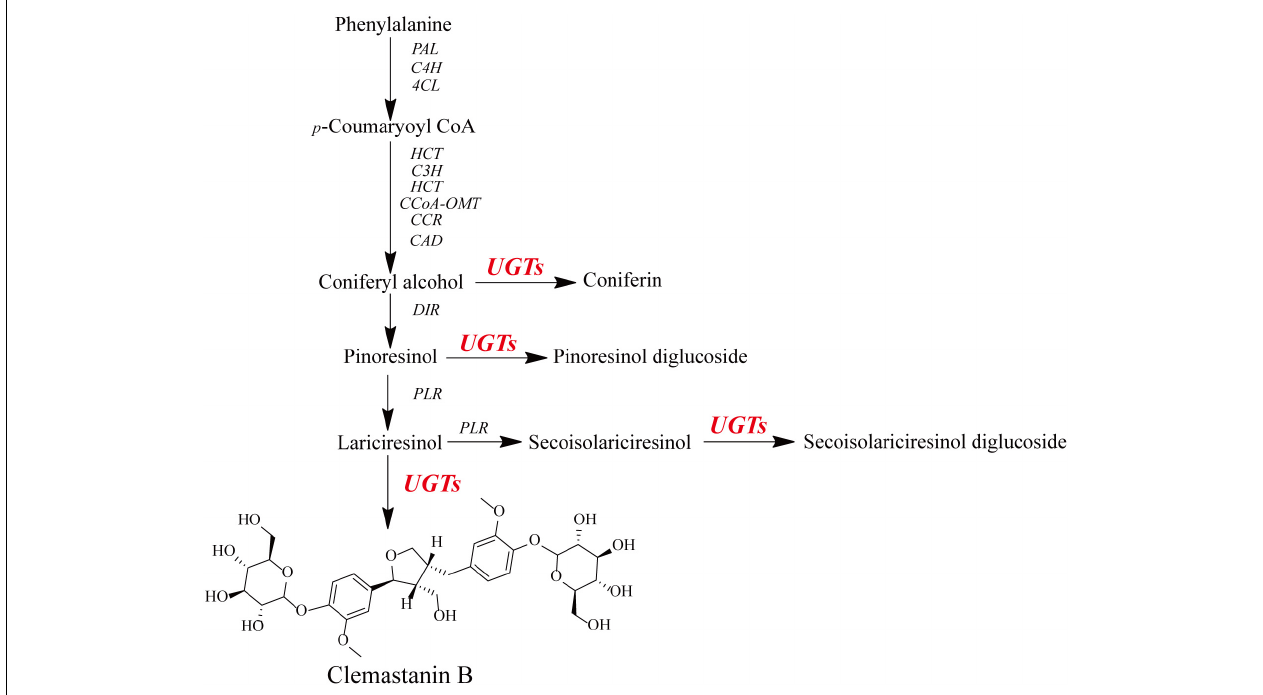
FIGURE 1 | Schematic for the putative biosynthetic pathway of O -glycosylation toward lignans in I. indigotica